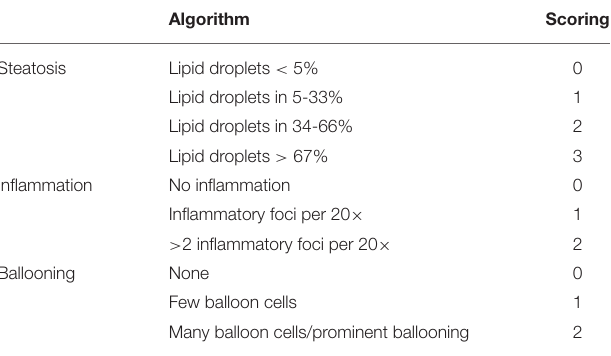
TABLE 1 | Histopathological algorithm and scoring system (21). Algorithm